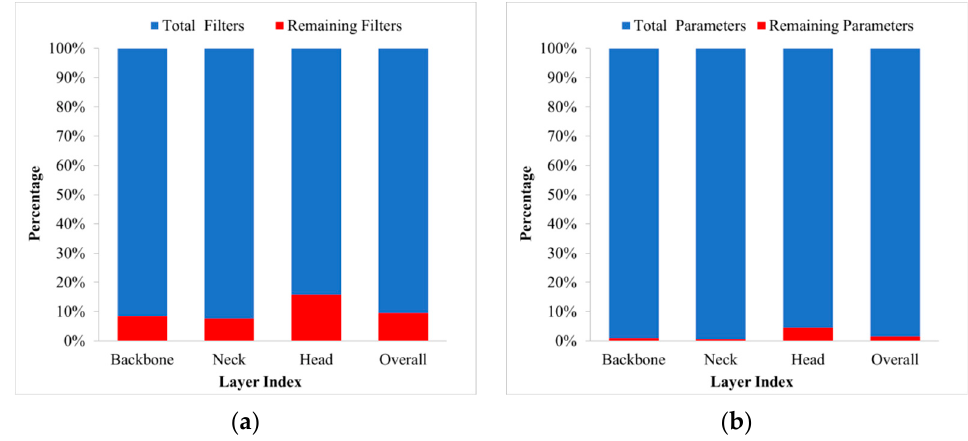
Figure 13. Changes in filters and parameters before and after pruning: ( a ) change in filters, ( b ) change in parameters.